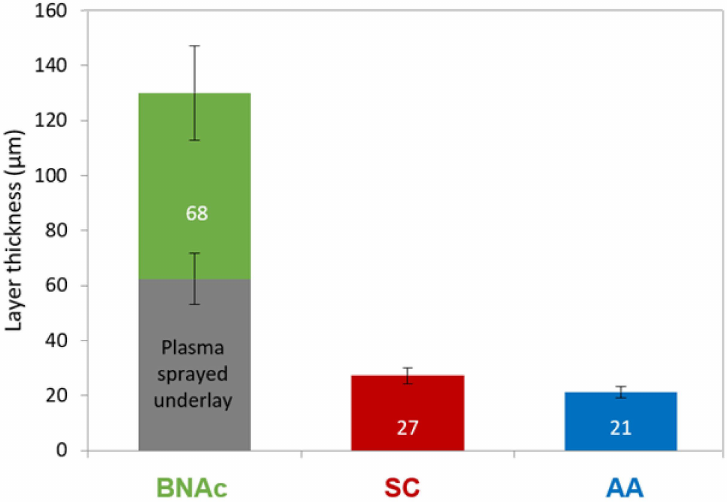
Figure 9. Coating